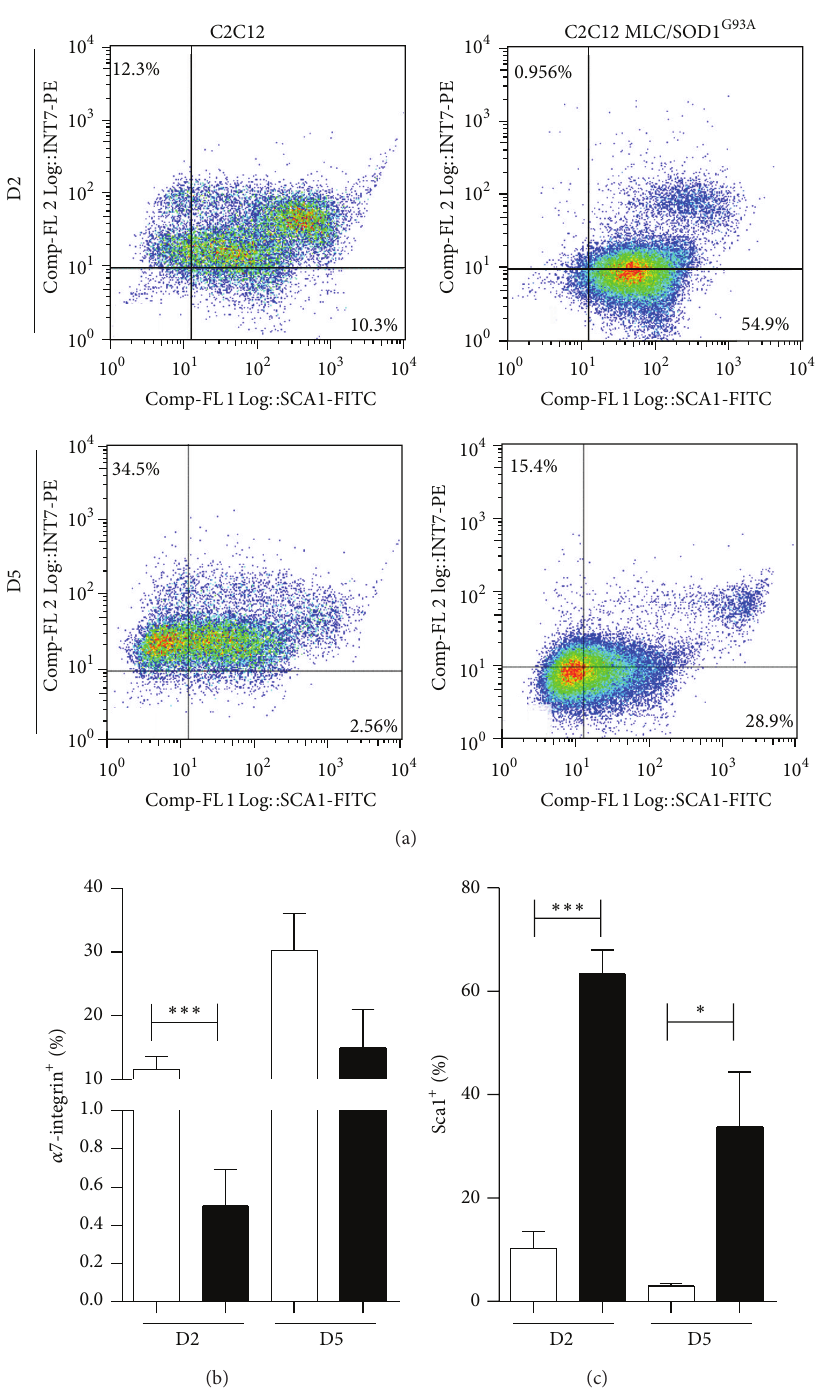
Figure 6: Expression of mutant SOD1 promotes a FAPS phenotype in C2C12 cells. (a) Flow cytometry profile for 𝛼 7 integrin and Sca1 expression from control C2C12 and transfected C2C12 MLC/SOD 1 G 93 A cells at days 2 and 5 in differentiation medium. (b, c) Histograms of the percentage of 𝛼 7 integrin (b) and Sca1 (c) positive cells of C2C12 (white bars) and C2C12 MLC/SOD 1 G 93 A (black bars) cells. D2 and D5 referred to days of culture in differentiation condition. Data are represented as mean ± SEM ( ∗ 𝑃 < 0.05 ; ∗∗∗ 𝑃 < 0.0005